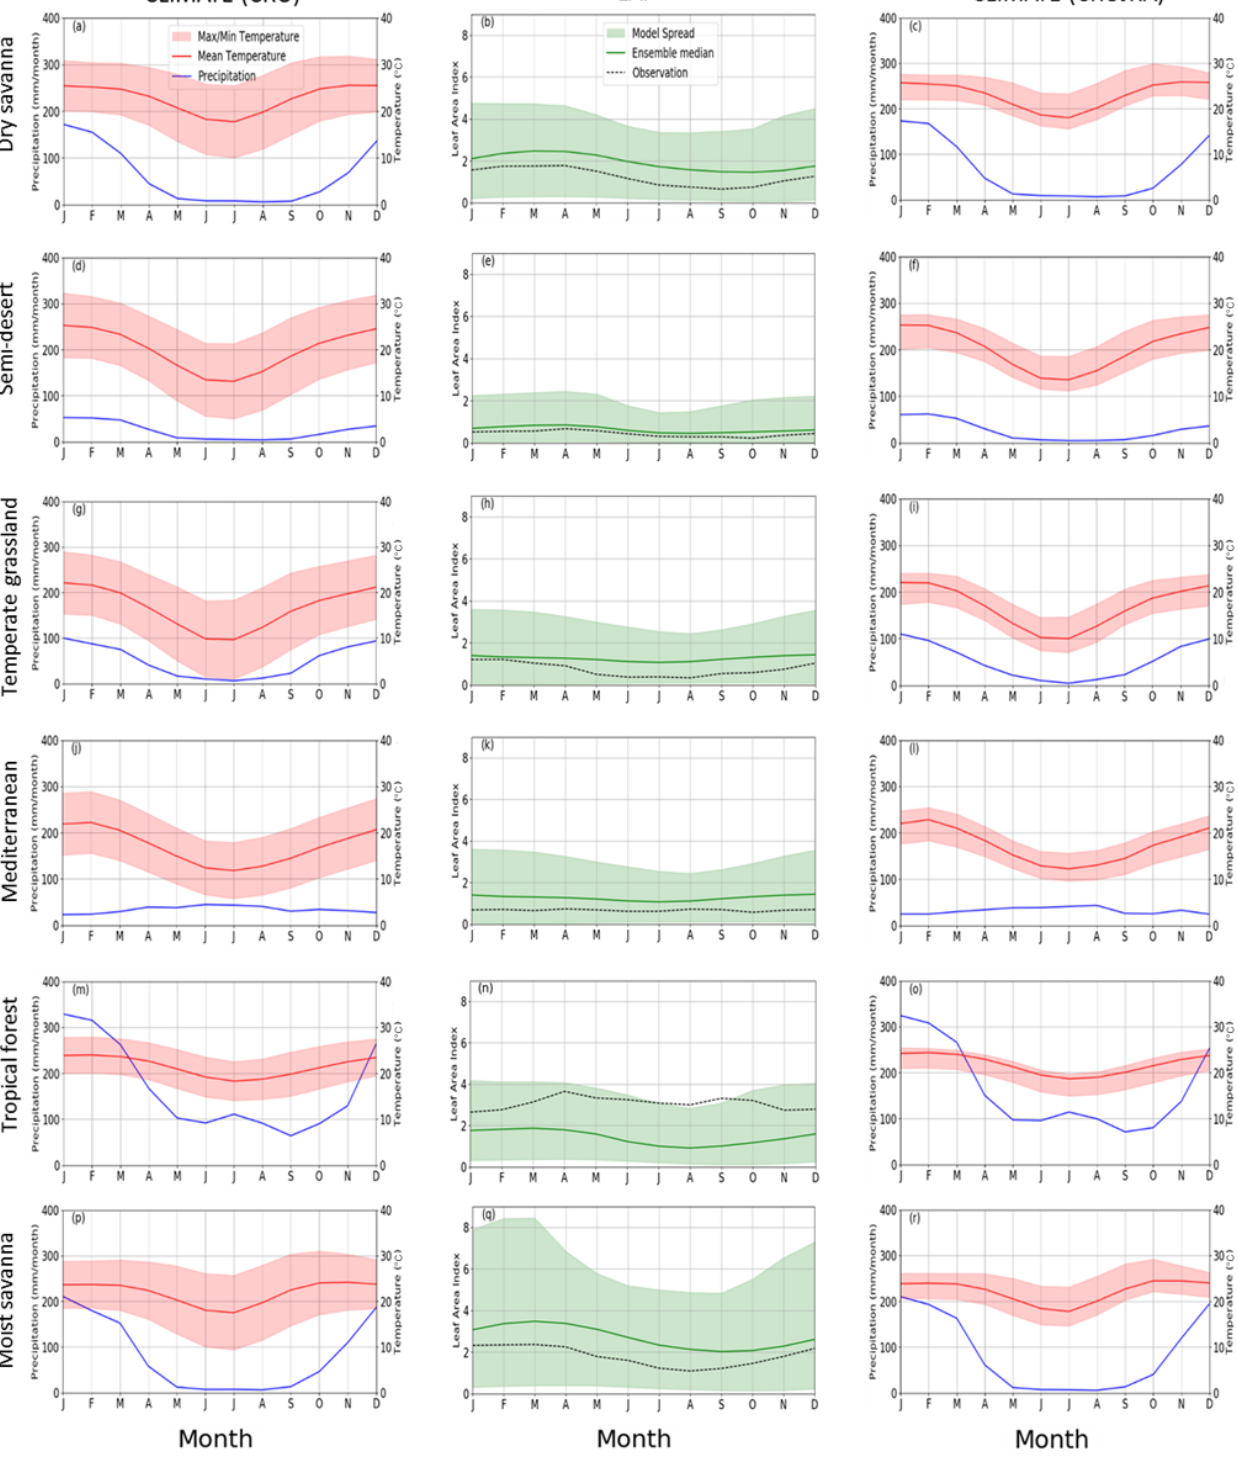
Figure 4. Annual cycle of observed climate variables (precipitation in millimetres per month; maximum, minimum, and mean temperature in degrees Celsius) and LAI for observation and multimodel mean (TRENDY) across six southern African biomes for the period 1982–2011. The annual cycle of the LAI for individual models is shown in Fig.